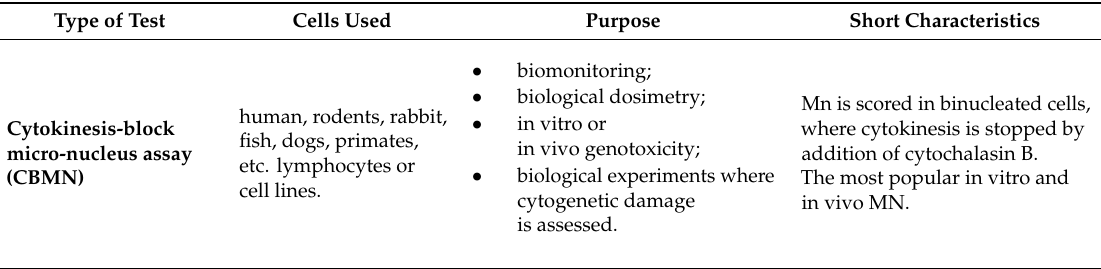
Table 3. Types of micronucleus